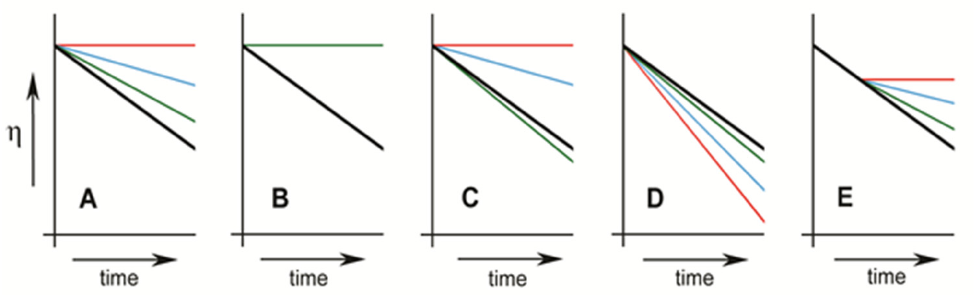
Figure 3. Panels ( A – D ) represent the results of assessing the substance functioning as a preventive antioxidant. Panel ( E ) schematically shows the η functional dependence observed when applying a chain-breaking antioxidant.